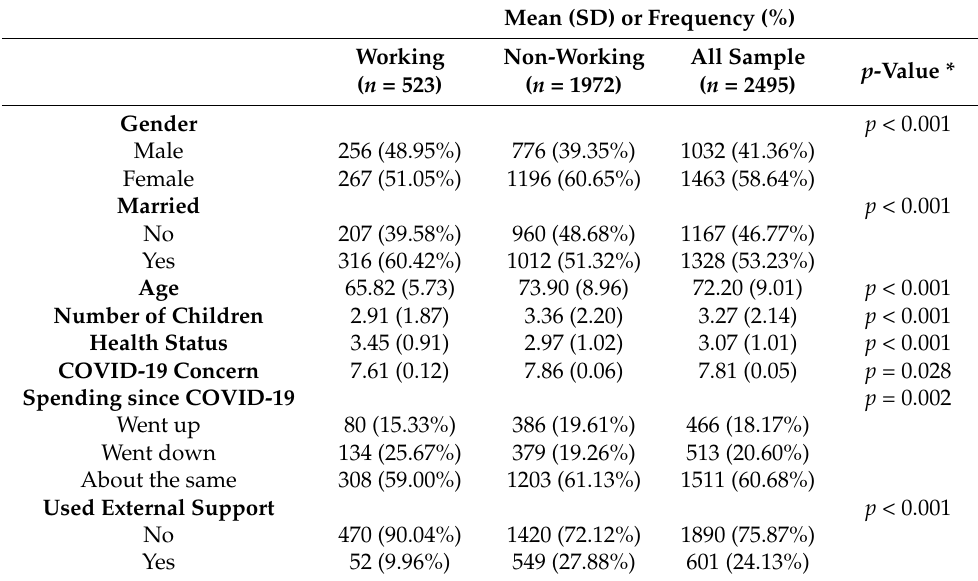
Table 1. Descriptive Statistics of Study Sample by Working Status.